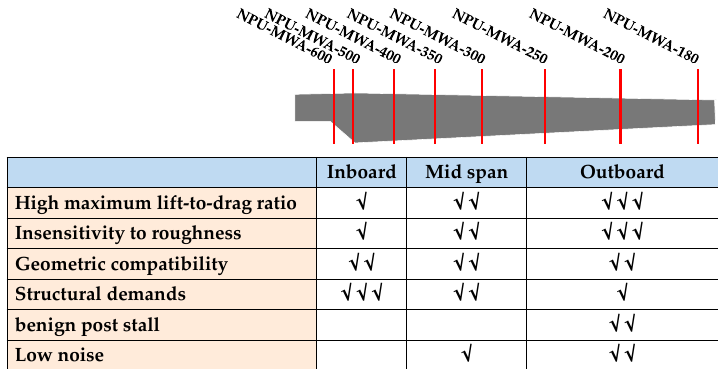
√ indicates greater